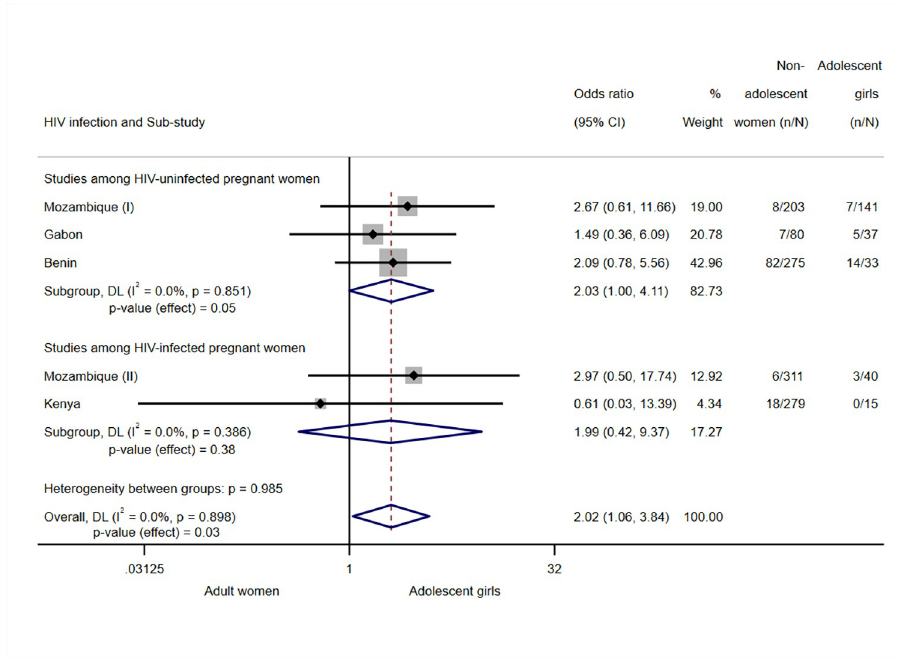
Fig 4. Analysis for peripheral PCR-confimed infection at delivery. Note: Analyses adjusted by trial arm, gravidity, literacy, gestational age at recruitment, MUAC, anaemia at recruitment, adherence to the treatment (IPTp), and season at recruitment. Weights and between-subgroup heterogeneity test are from random-effects model. Tanzania (I), HIV- uninfected participants, and Tanzania (II), HIV-infected participants, were excluded from the analysis since no cases of PCR-confirmed peripheral infection at delivery were found among study participants in the site. CI, confidence interval; DL, DerSimonian–Laird random effects model; MUAC, mid-upper arm circumference; OR, odds ratio.